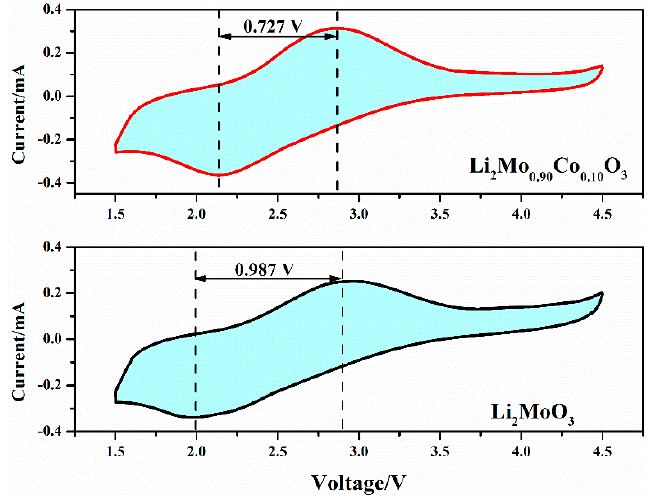
Figure 9. CV curves of Li 2 MoO 3 and Li 2 Mo 0.90 Co 0.10 O 3 between 1.5 and 4.5 V at the 5th cycle.